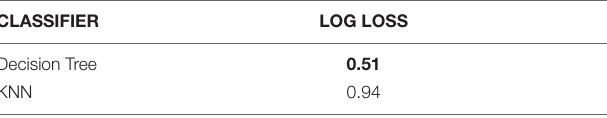
TABLE 3 | Log loss function values of decision tree and KNN. TABLE 4 | The performance of our method by using different features.